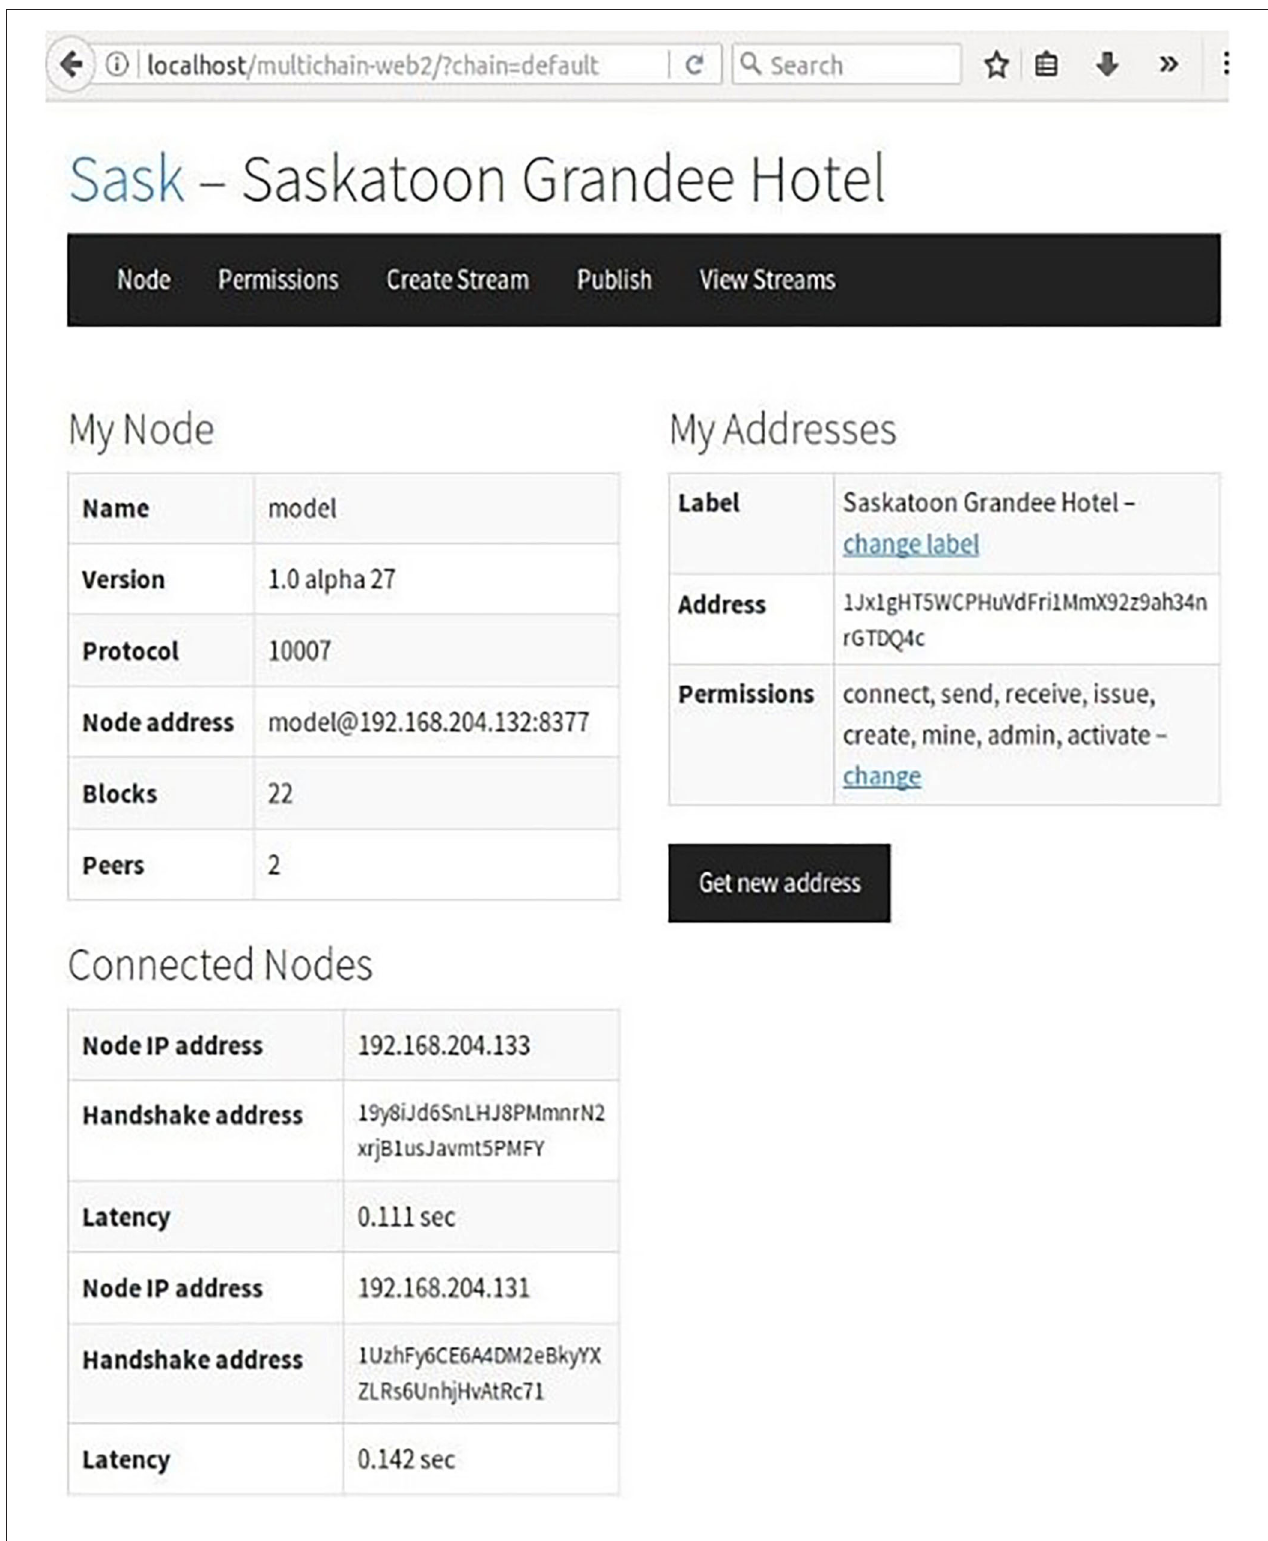
FIGURE 3 | All connected nodes as seen from Node 1- Grandee Hotel .